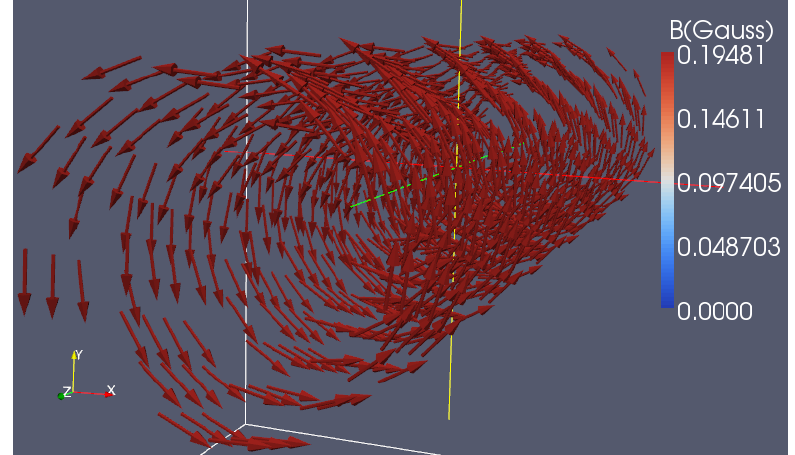
Figure 2. A rendering of the three-dimensional distribution of well-ordered magnetic field within the TEMZ grid. Each vector depicts the magnetic field orientation within an individual plasma cell, and is color-coded according to the strength of the field (see color bar to the